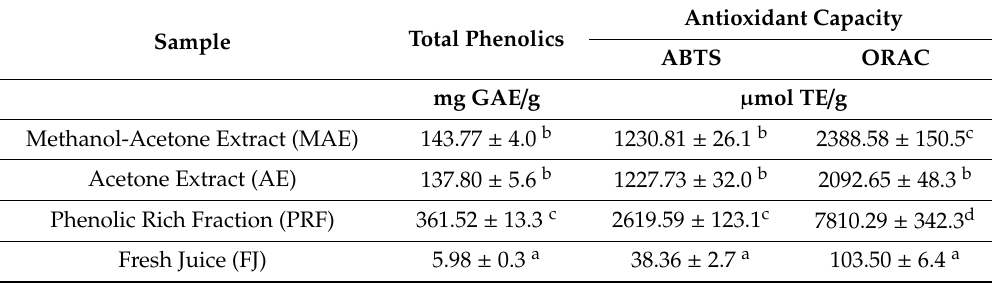
Table 2. Total phenolic content of Viburnum opulus samples and their antioxidant capacity estimated by ABTS and ORAC